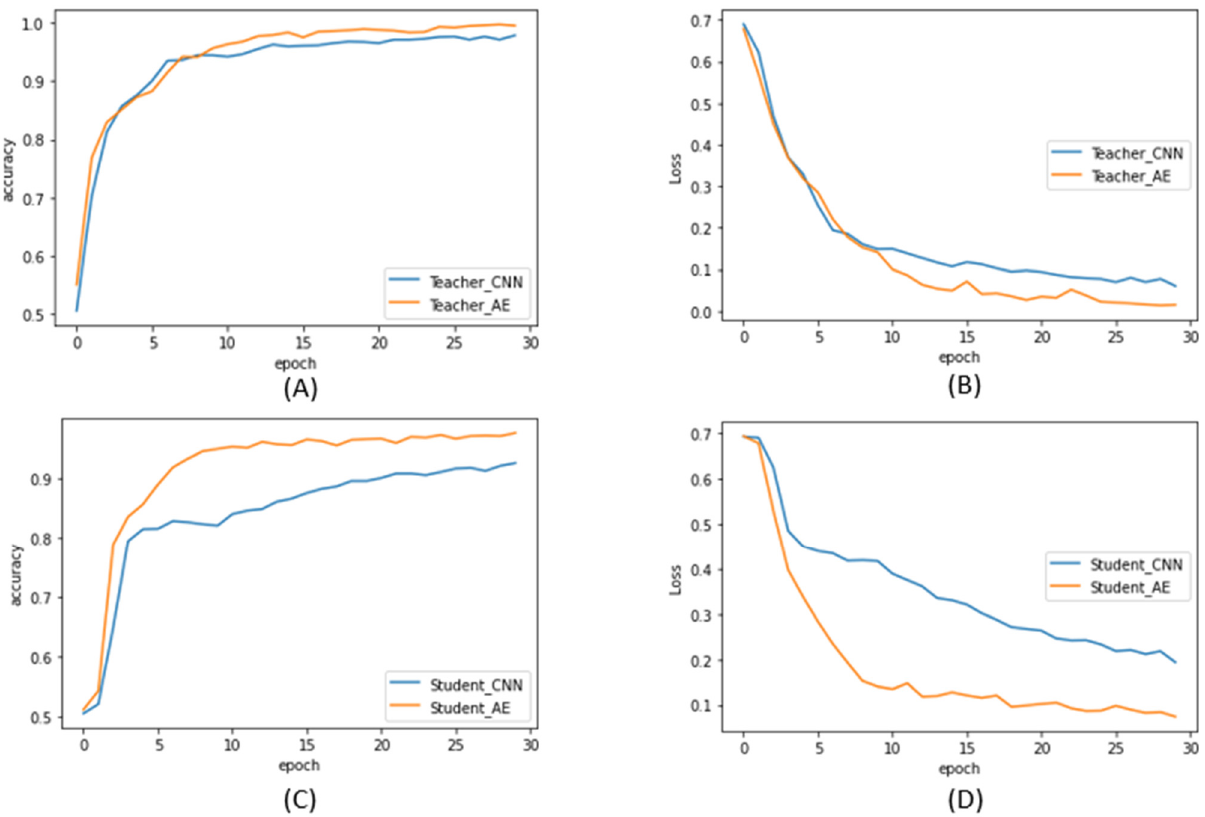
Figure 8. Accuracy and loss Graphs of CNN and AE models for teacher and student models: ( A ) teacher CNN and AE ACC; ( B ) teacher CNN and AE loss; ( C ) student CNN and AE ACC; ( D ) student CNN and AE loss.